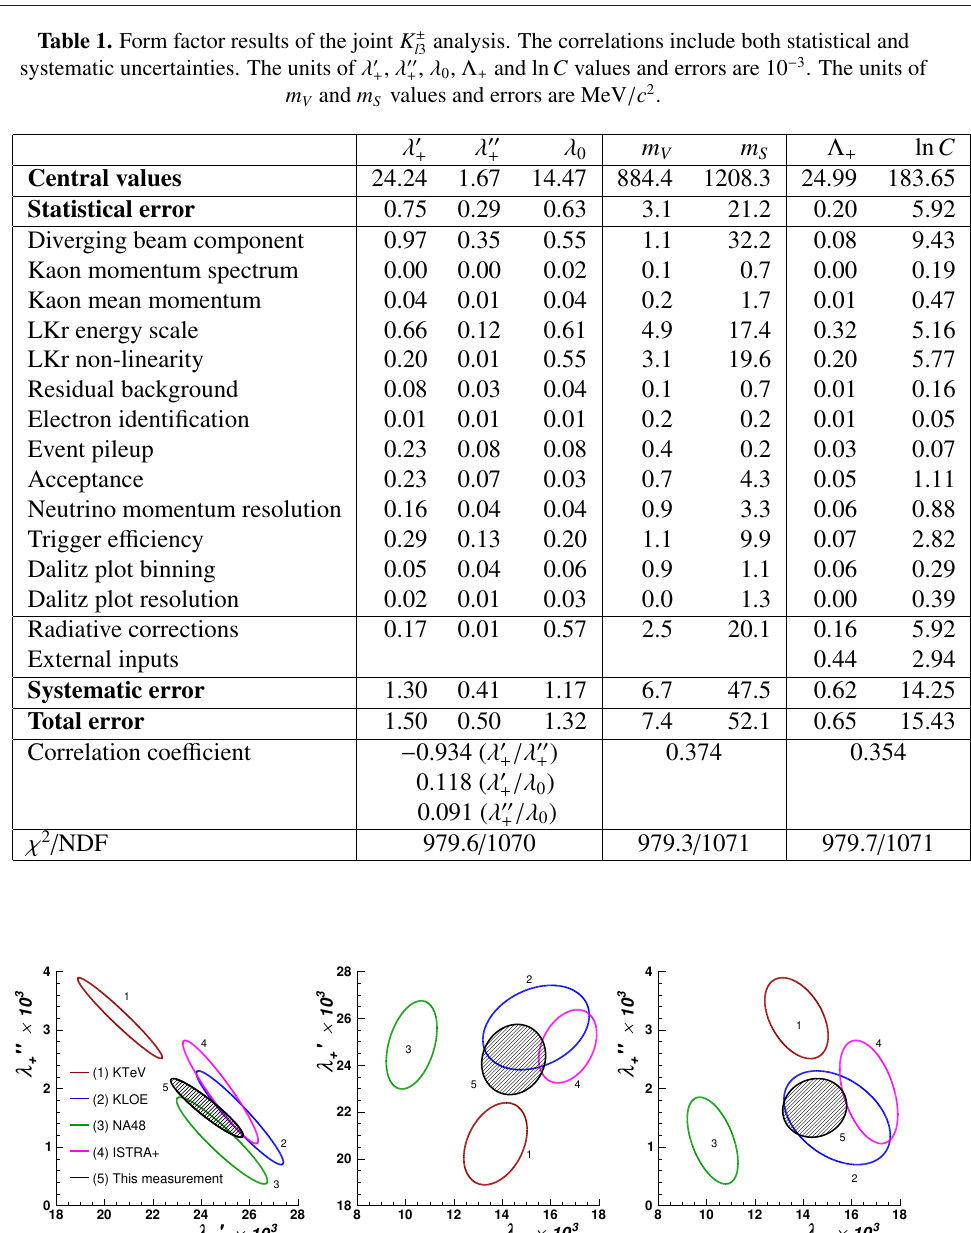
Table 1. Form factor results of the joint K ± systematic uncertainties. The units of λ ′